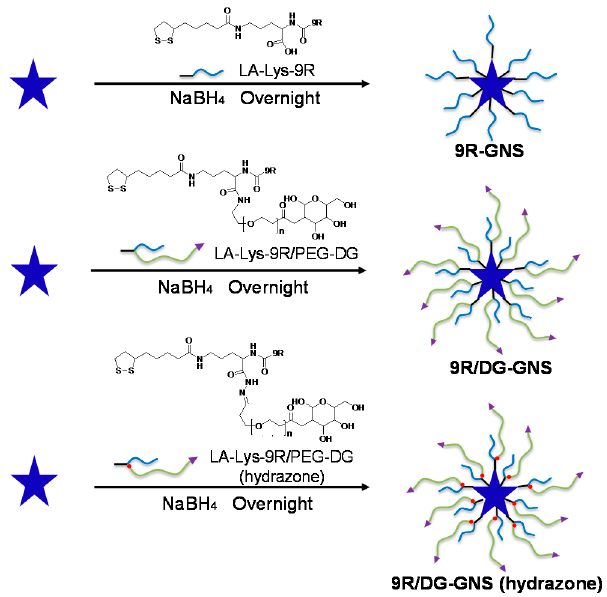
Figure 1. Synthesis of 9R-GNS, 9R/DG-GNS and 9R/DG-GNS (hydrazone) using ligands LA-Lys-9R, LA-Lys-9R/PEG-DG, and LA-Lys-9R/PEG-DG (hydrazone), respectively. The starting materials (the left blue star) is bared GNS, which were synthesized by seed-mediated growth method. GNS, gold nanostars; DG, 2-deoxyglucose; 9R, 9-poly- D -arginine; PEG, polyethylene glycol; LA, α -Lipoic acid.